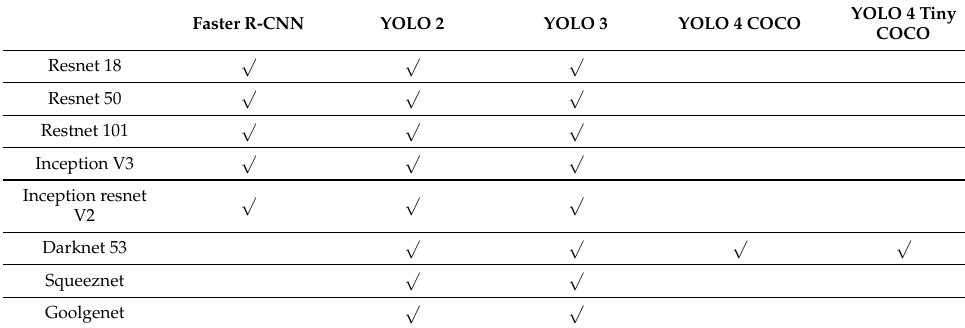
Table 22. Different evaluated DL architectures with different feature extractor networks.